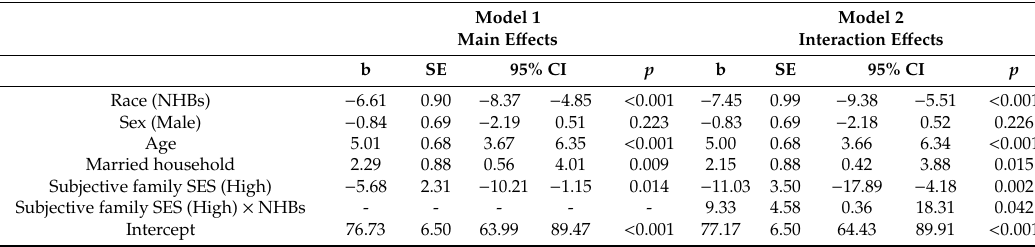
Table 3. Summary of linear regressions overall ( n = 4188) .